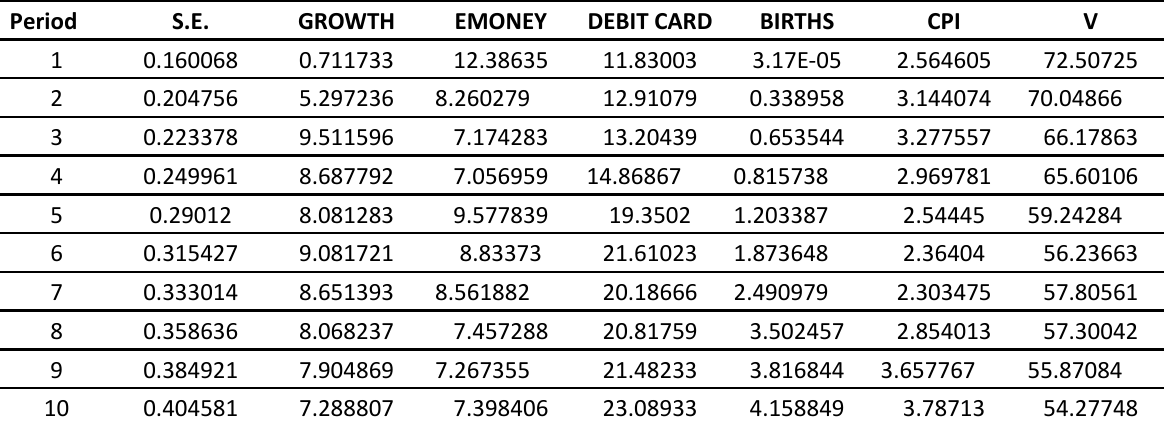
Table 9: Results of Forecast Error Variance Decomposition (FEVD) from the Velocity of